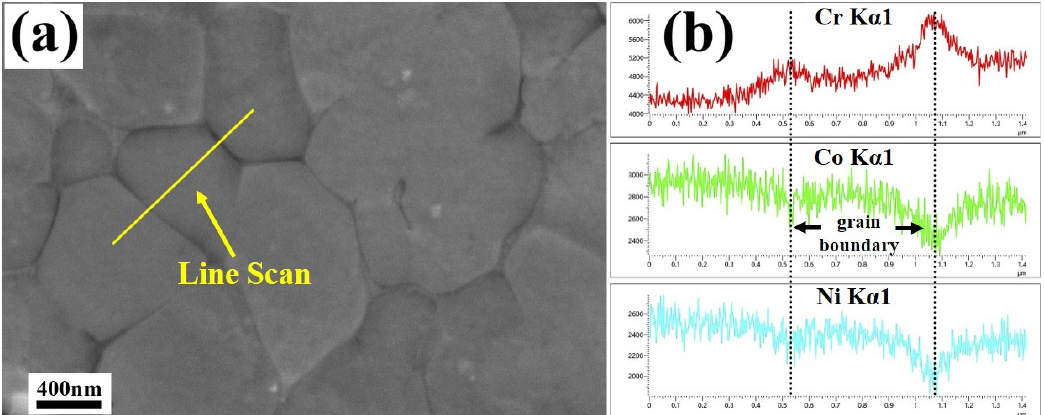
Figure 5. High-magnification BSE-SEM images ( a ) and line scan analysis ( b ) of the recrystallization region (Region b in Figure 4a). A line scan was conducted across two grain boundaries as displayed in ( a ), the corresponding locations of which are labeled with dashed lines in ( b ).